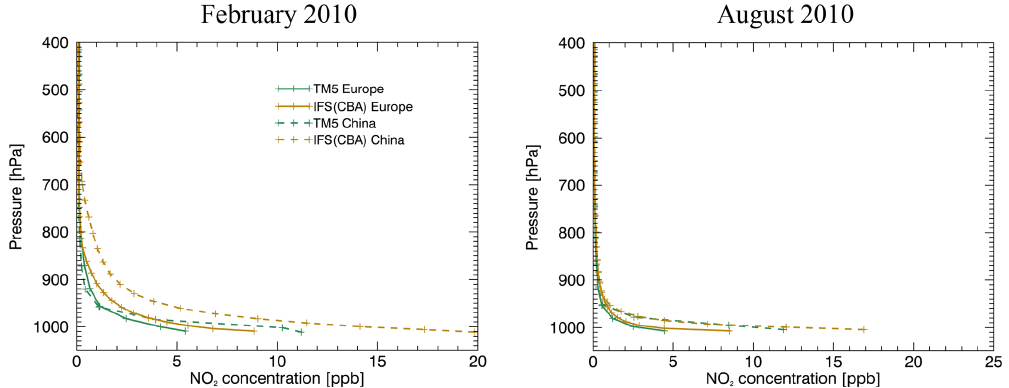
Figure 6. Area-averaged and monthly averaged profiles from TM5-MP and IFS (CBA) at the GOME-2 overpass time (09:30LT) over western Europe (44–53 ◦ N, 0–7 ◦ E) and eastern China (21–41 ◦ N, 110–122 ◦ E) in February and August